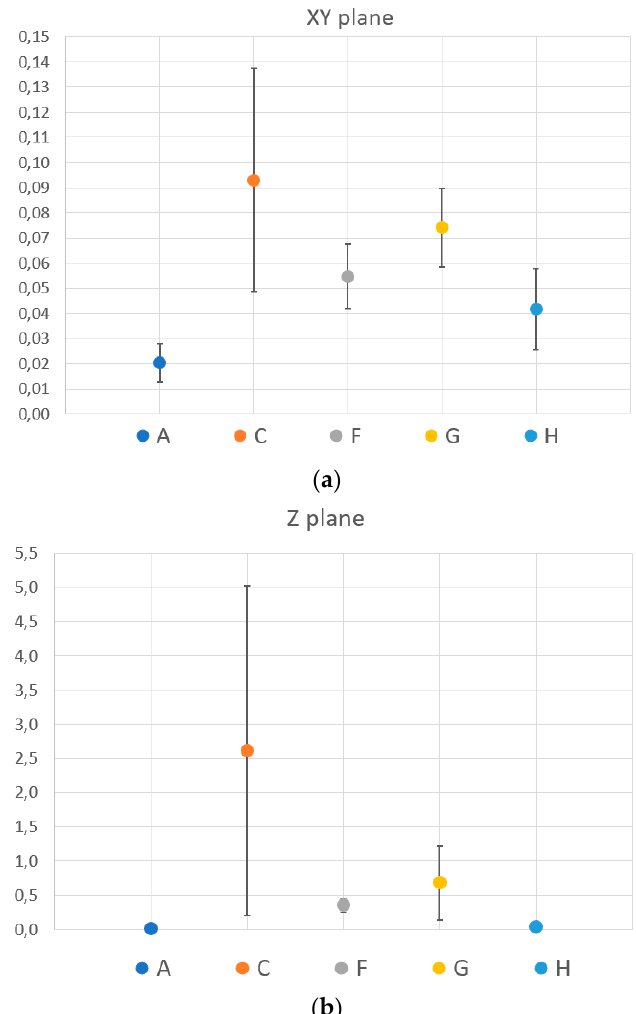
Figure 26. Percentage of residual defects on the polished surfaces of the ( a ) XY, ( b ) XZ surfaces. J. Manuf. Mater. Process. 2019 , 3 , x FOR PEER REVIEW